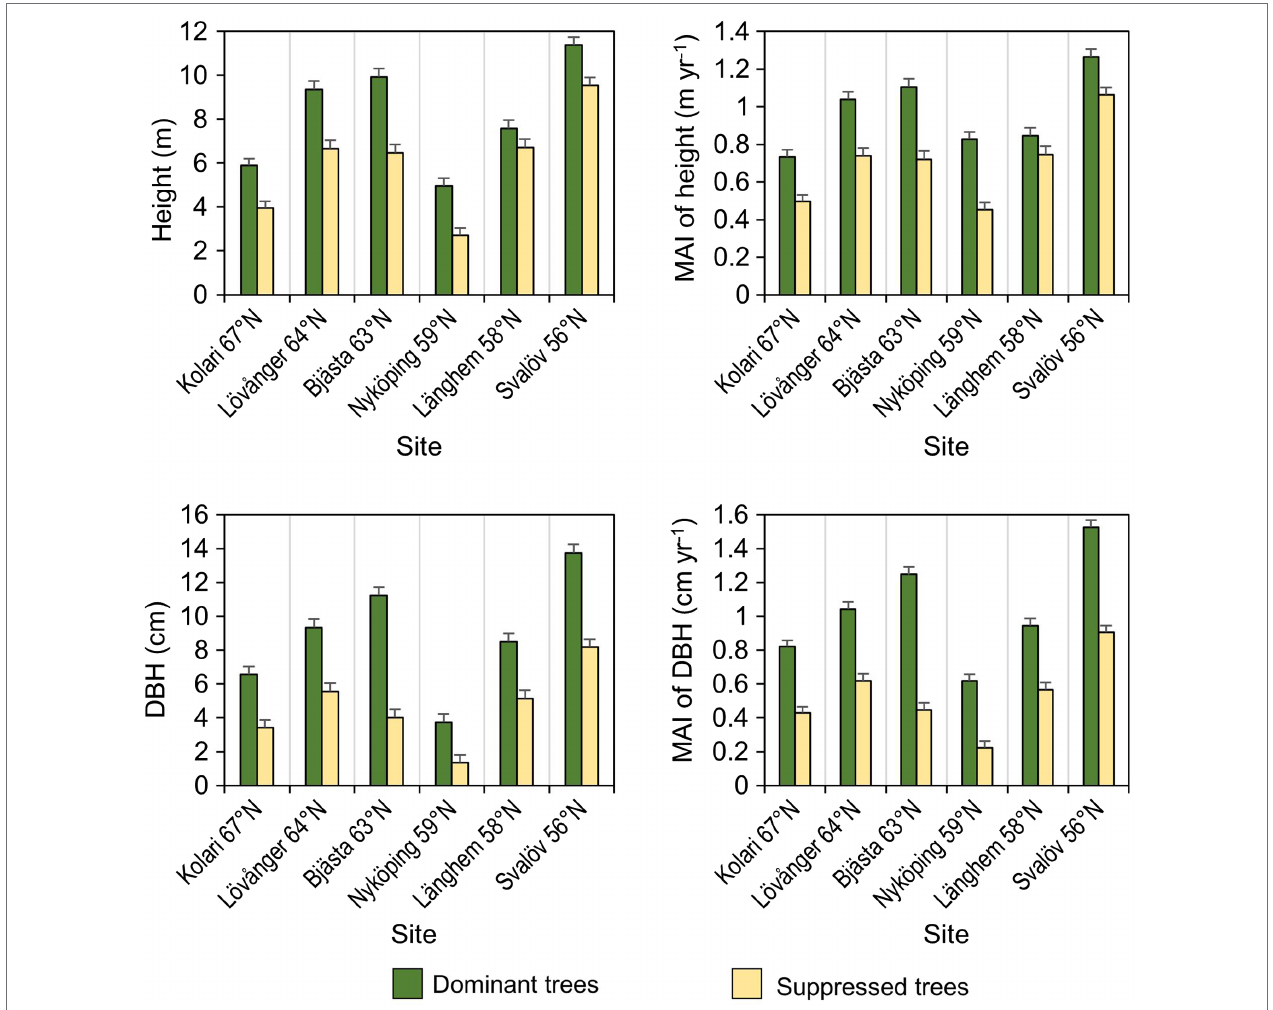
FIGURE 3 | Mean (±SE) growth characteristics (DBH, diameter of the stem at breast height; MAI, mean annual increment) of the sample trees ( n =